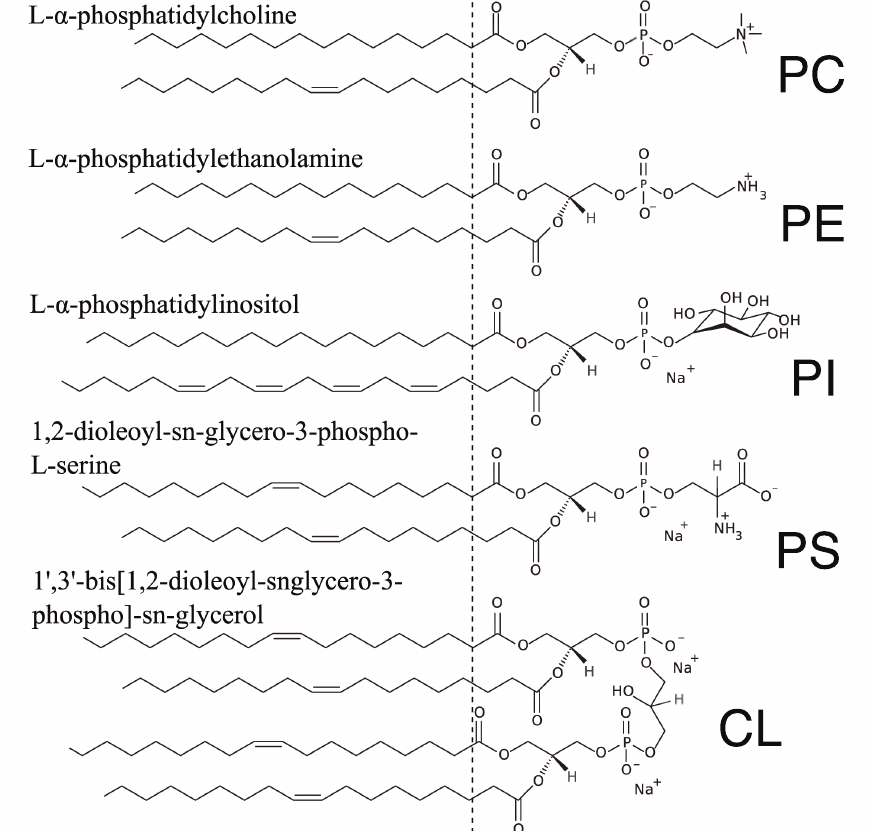
Figure 1. Lipid composition of the mitochondria-like membrane. A model mitochondria-like membrane was obtained by mixing naturally-extracted phosphatidylcholine (PC), naturally-extracted phosphatidylethanolamine (PE), naturally-extracted phosphatidylinositol (PI), synthetic 1,2-dioleoyl-sn-glycero-3-phospho- L -serine (DOPS) and synthetic 1’,3’-bis[1,2-dioleoyl-sn-glycero-3-phospho]-sn-glycerol (TOCL) (see Table 2 for the exact proportions). For each headgroup type, the skeletal formula of the most abundant species is represented, although for the naturally-extracted lipids, a variety of different tails are in fact present. The vertical line marks the transition from the acyl chain region to the lipid headgroup